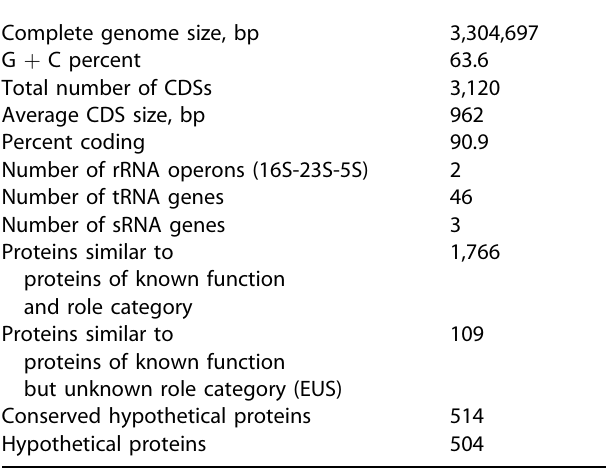
Table 1. General Features of the M. capsulatus (Bath) Genome Complete genome size,